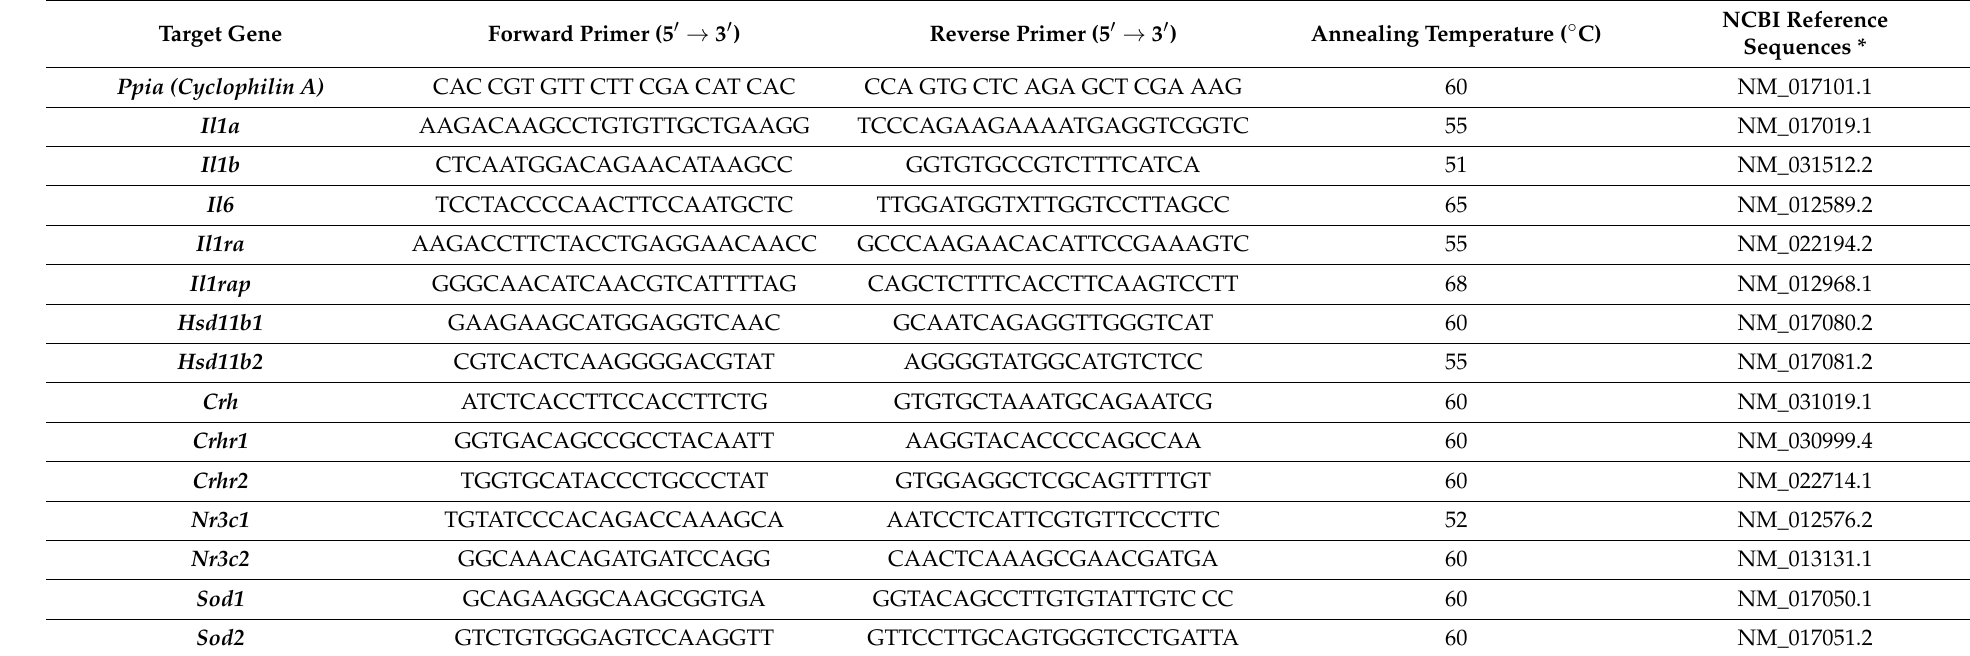
Table 2. Primer forward and reverse sequences and annealing temperatures for